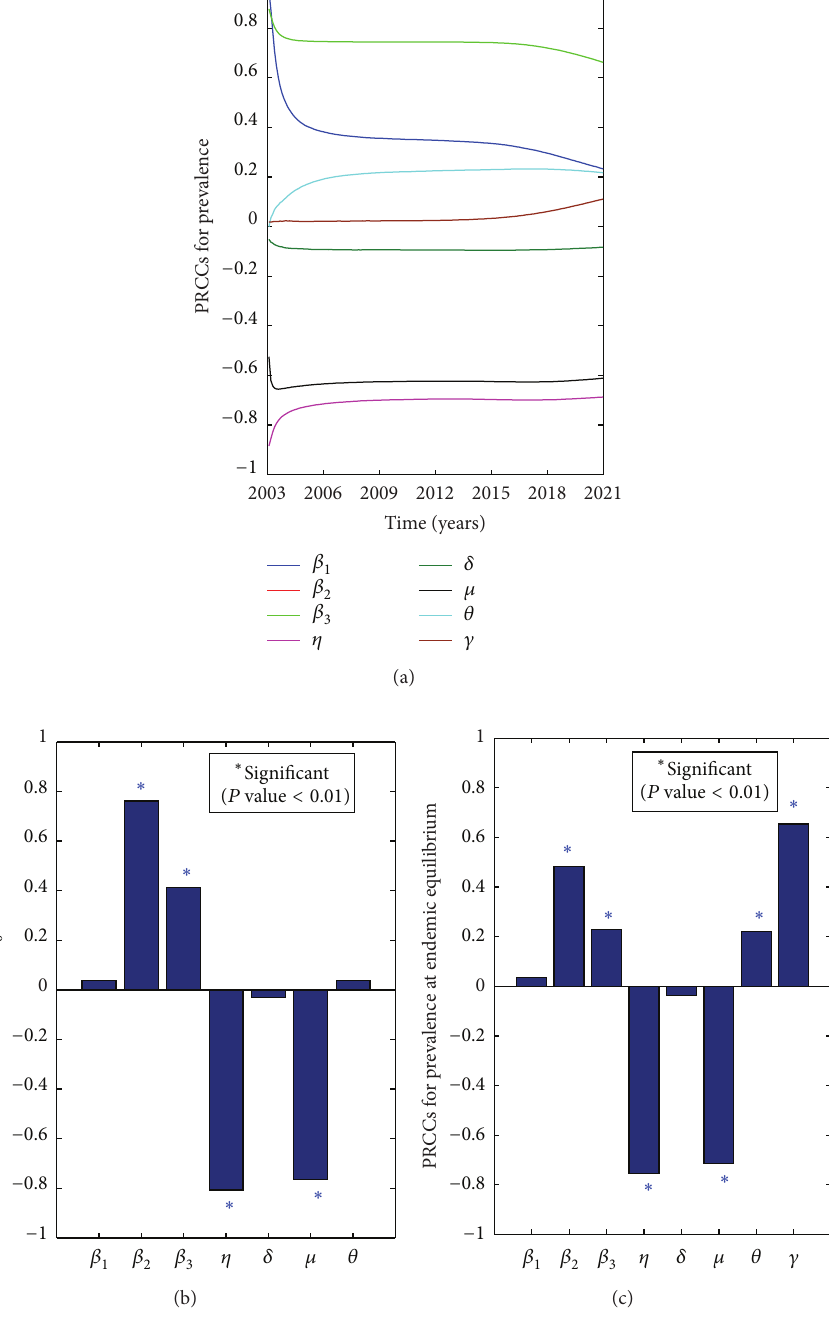
Figure 5: (a) PRCCs of the eight parameters for prevalence from 2003 to 2021. (b) PRCCs for 𝑅 0 . (c) PRCCs for the equilibrium prevalence. Sample size is set to 2000. ∗ denotes PRCCs are significant ( 𝑃 value < 0.01 ). Parameter values and ranges are as shown in Tables 1 and 2.